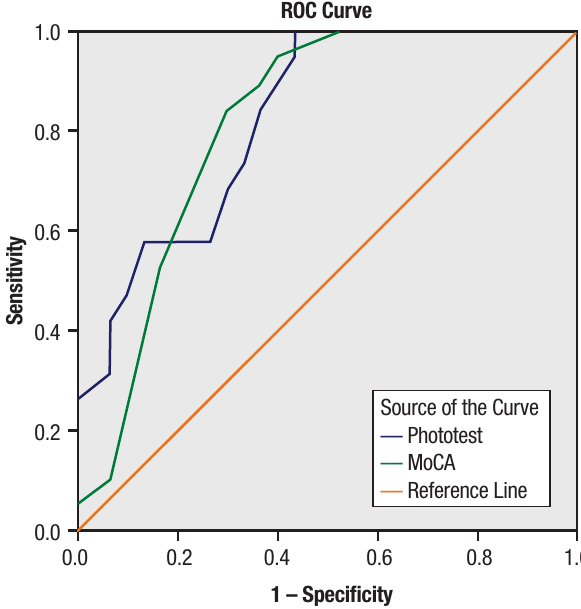
Figure 1. Receiver operating curve generated by the two neurocognitive